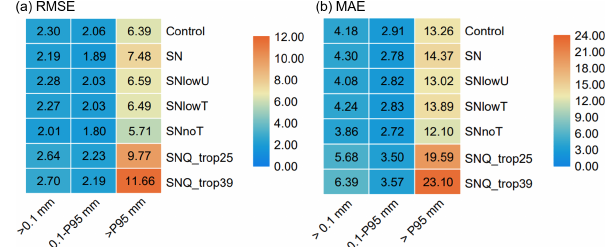
Figure 4. (a) Root-mean-square error (RMSE) and (b) mean ab- solute error (MAE) of precipitation (mmd − 1 ) from WRF simula- tions against CMORPH at different precipitation thresholds (P95: monthly mean precipitation intensity at 5.73mmd − 1 ). Color shad- ing represents the performance of each WRF simulation, where more intense blue indicates a smaller bias in the simulation and more intense orange indicates a larger bias in the